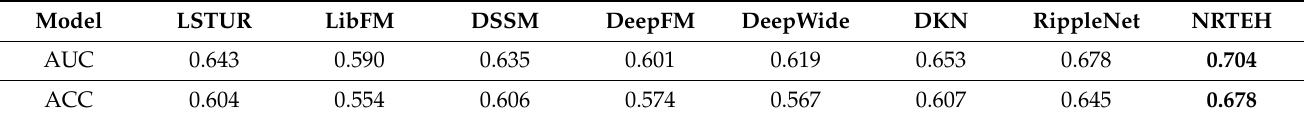
Table 2. The results for AUC and accuracy in CTR prediction.